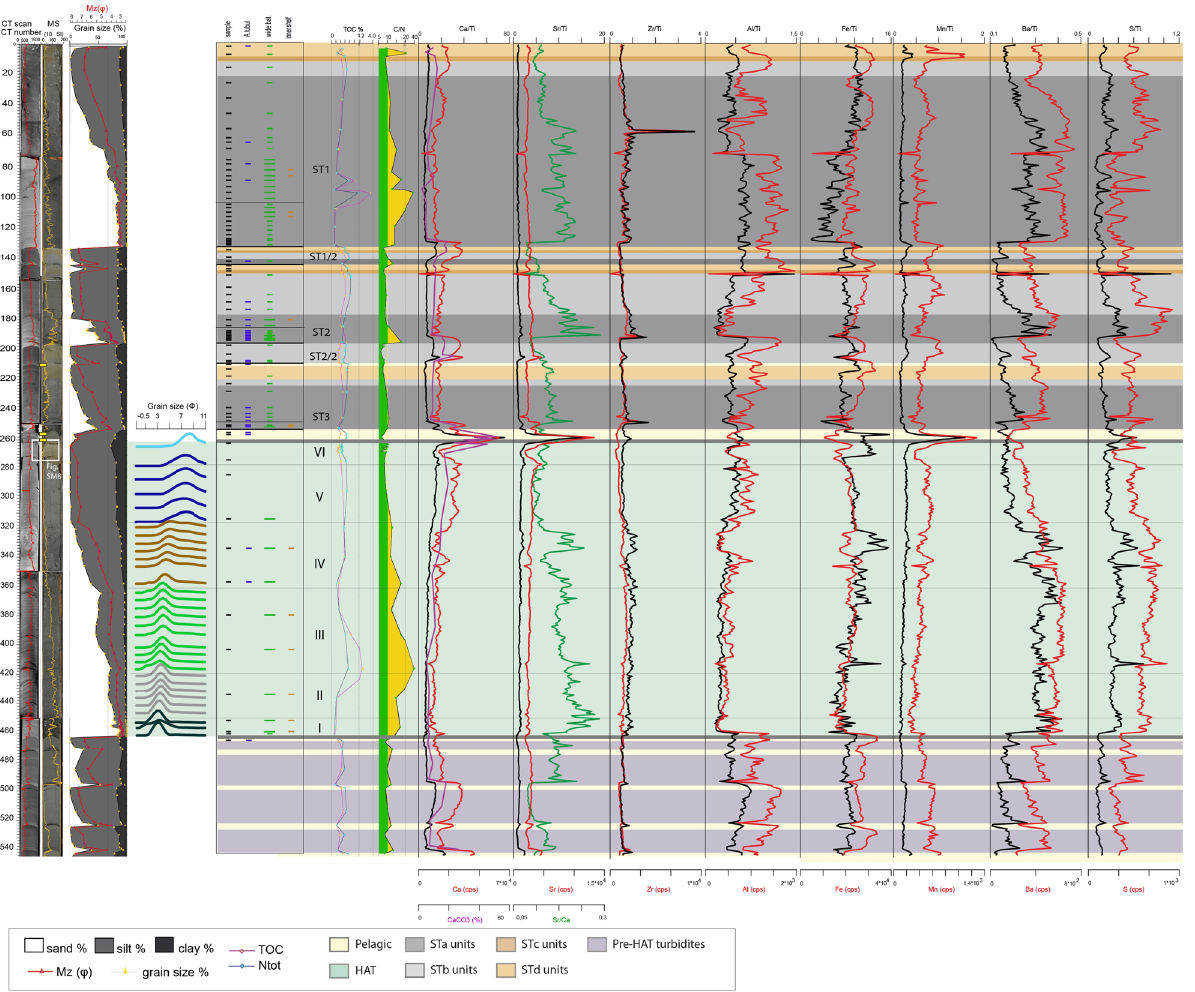
Figure 5. Log of core CQ14_02. From left to right: CAT scan with HU (Hounsfield Unit) in red color, photograph with high-resolution magnetic susceptibility in yellow, grain size % with mean diameter in magenta, grain size modes in different colours for each sediment unit within the HAT, benthic foraminifera assemblages, sedimentary facies for ST1, ST2 and ST3 in different colors 4 , subdivision in individual HAT units (I-VI) in green and pelagic units identified by different colors, organic carbon data (TOC%, N tot , and C/N: green areas if C/N < 10, yellow areas if C/N > 10) and XRF data plot along the study sample. Yellow rectangle on the CAT scan image, represents 14 C dated samples (SM1). Benthic foraminiferal assemblages are grouped in three different classes: blue = abyssal species (mainly A. tubulosa); green = wide bathymetric ranges; brown = inner shelf (see Tables 2, SM6 and SM7 for more details). Thin sample rectangles represent 0,5 cm thick samples. Thick sample rectangles represent 1 cm thick samples. Small coloured rectangles = rare specimens: < 25 specimens in 0.03 g of sample; large coloured rectangles = common specimens: > 25 specimens in 0.03 g of sample (see Table 2 for details on the bathymetric distribution). Identified seismo-turbidites (ST1, ST2 and ST3) with individual units (a, b, c and d) are indicated. The white rectangle at about 260–270 cm depth refers to Fig.